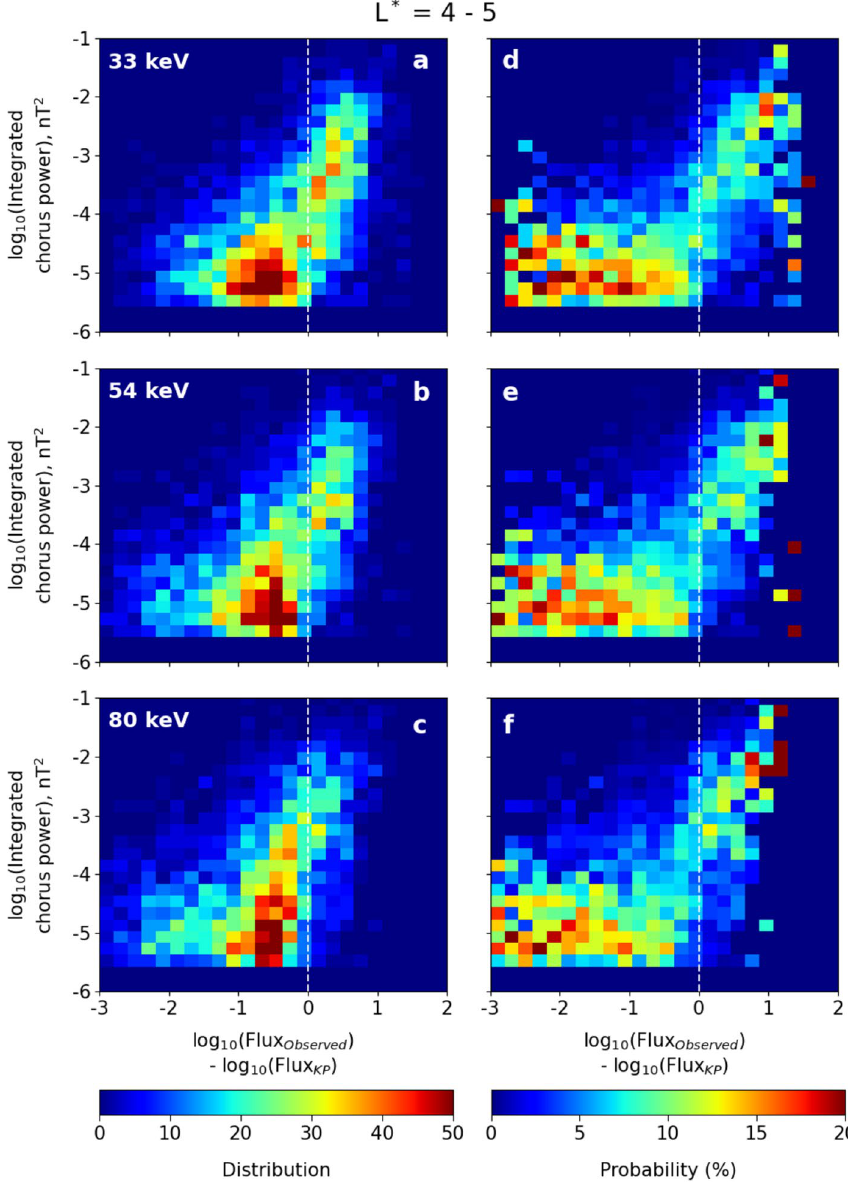
Figure 4. ( a – c ) Two dimensional histograms and ( d – f ) probability distribution functions (PDFs) of integrated chorus wave power against the logarithm of the ratio of the observed flux to the calculated KP limit. The plots are in log-log space for ( a , d ) 33 keV, ( b , e ) 54 keV and ( c , f ) 80 keV energy electrons within the L* range 4 − 5 . The colorbars at the bottom denote the distribution (number) of data points (left column) and probability (right column) of finding a given chorus wave power at a given flux ratio, using bins having bin width of 0.2 × 0.2 in log-log space. The vertical dashed line in each panel indicates that the observed flux is equal to the KP